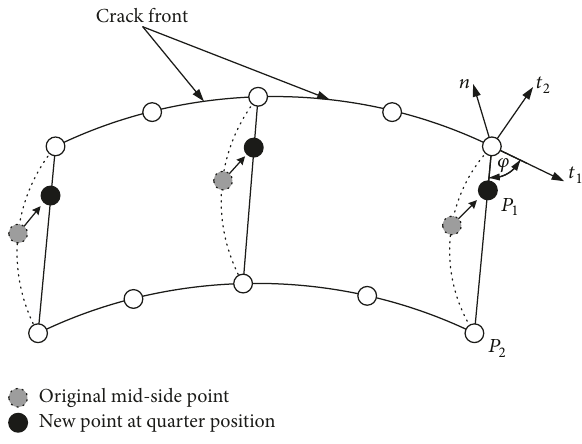
Figure 2: Generation of quarter point